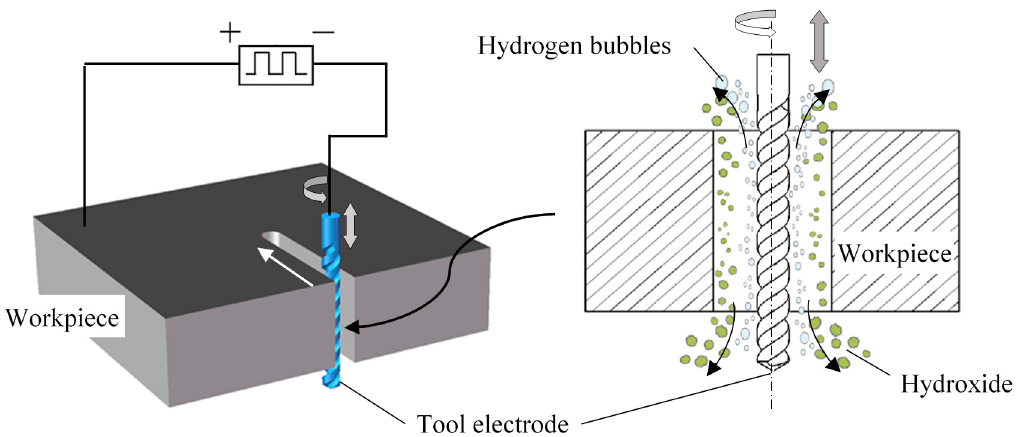
Figure 1. Schematic diagram of the ultrasonic-assisted wire electrochemical micromachining (UA-WECMM) method.